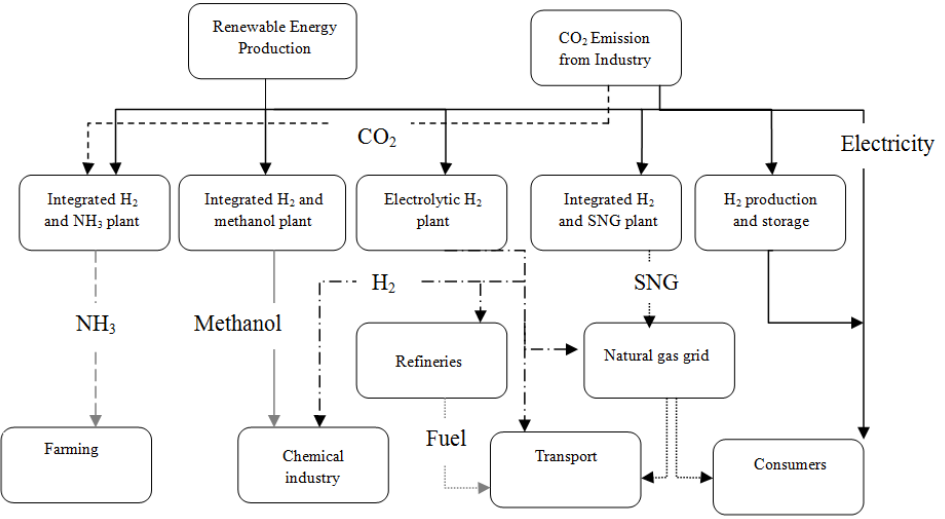
Figure 5. The holistic concept of modularized ammonia synthesis, reproduced from reference [31].